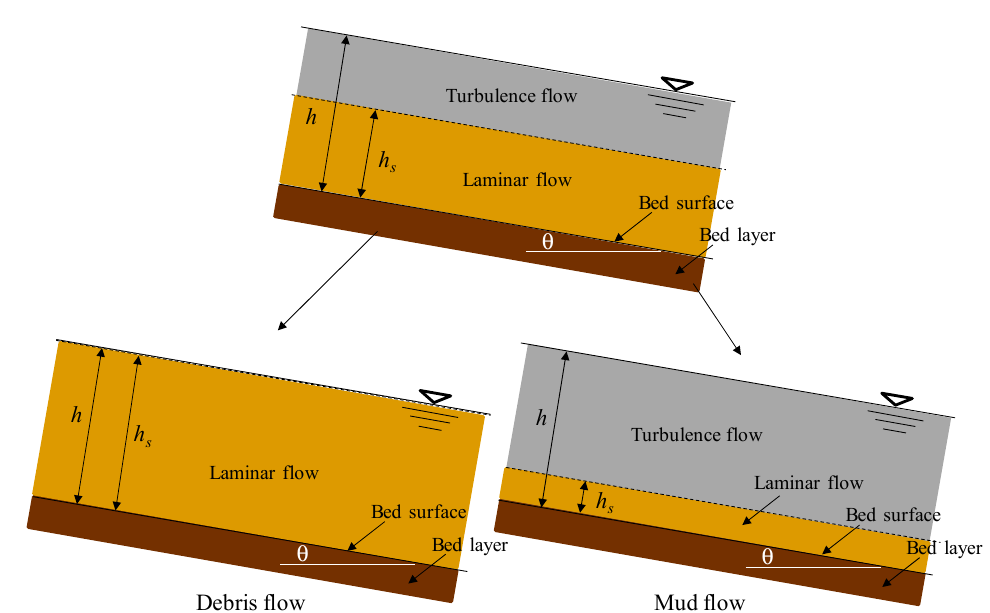
Figure 2. Schematic of the formation of laminar and turbulence flows and the relationship between debris flow and mud flow.